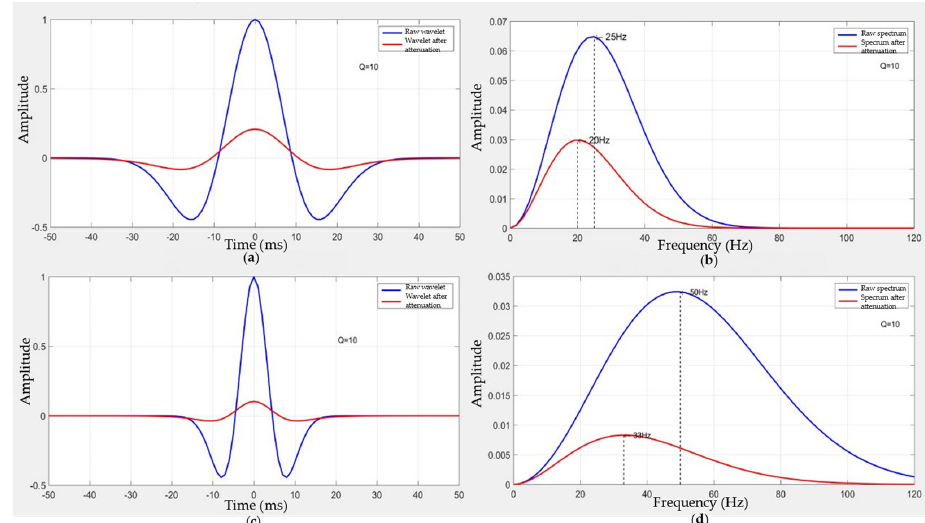
Figure 3. The Ricker wavelets of different dominant frequencies before and after attenuation: ( a ) The 25 Hz Ricker wavelet before and after attenuation, ( b ) The spectrum of the 25 Hz Ricker wavelet before and after attenuation, ( c ) The 50 Hz Ricker wavelet before and after attenuation, ( d ) The spectrum of the 50 Hz Ricker wavelet before and after attenuation.